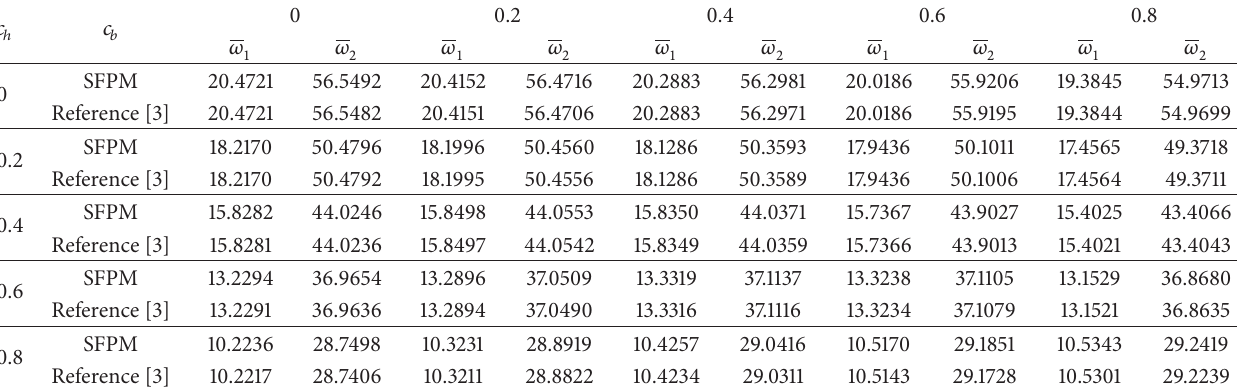
Table 7: Nondimensional transverse natural frequencies 𝜔 𝑖 for axially FG tapered beam; boundary condition: C-C.